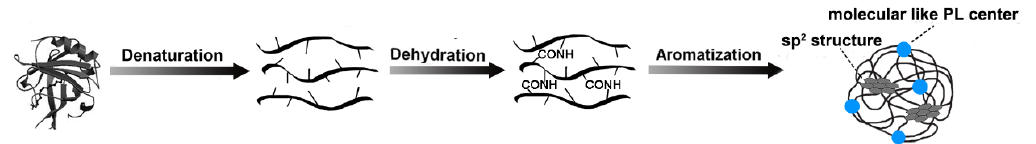
Figure 1. Scheme of the synthesis of the carbon nanodots (CNDs).